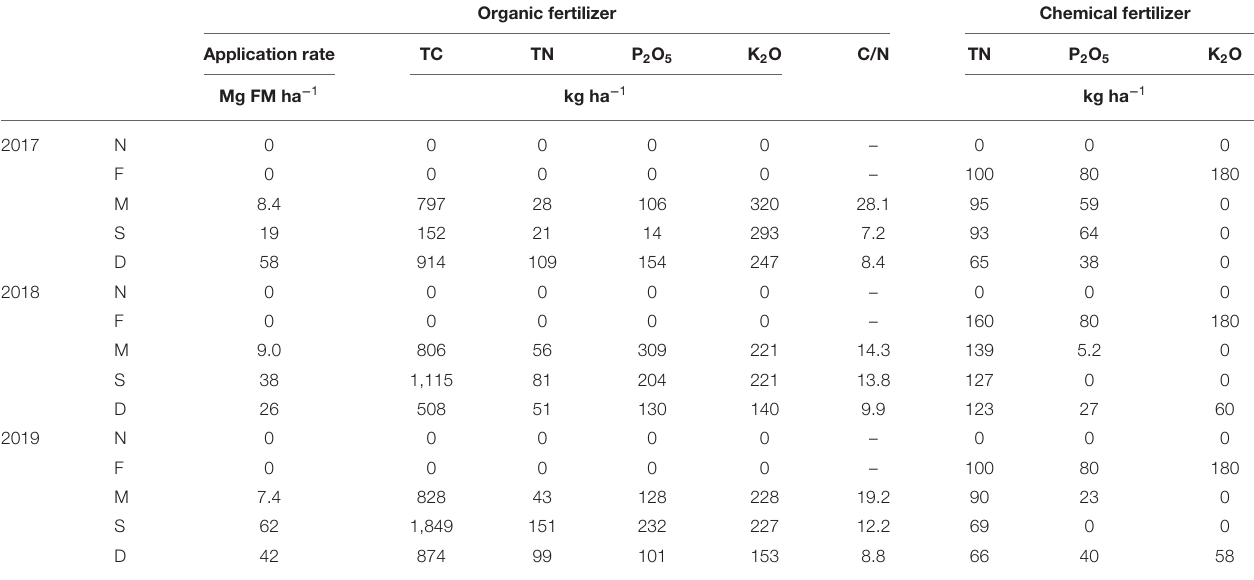
TABLE 2 | Annual organic fertilizer application rate each year, chemical fertilizer application to chemical fertilizer plots, and chemical fertilizer supply to organic fertilizer plots. Organic fertilizer Chemical